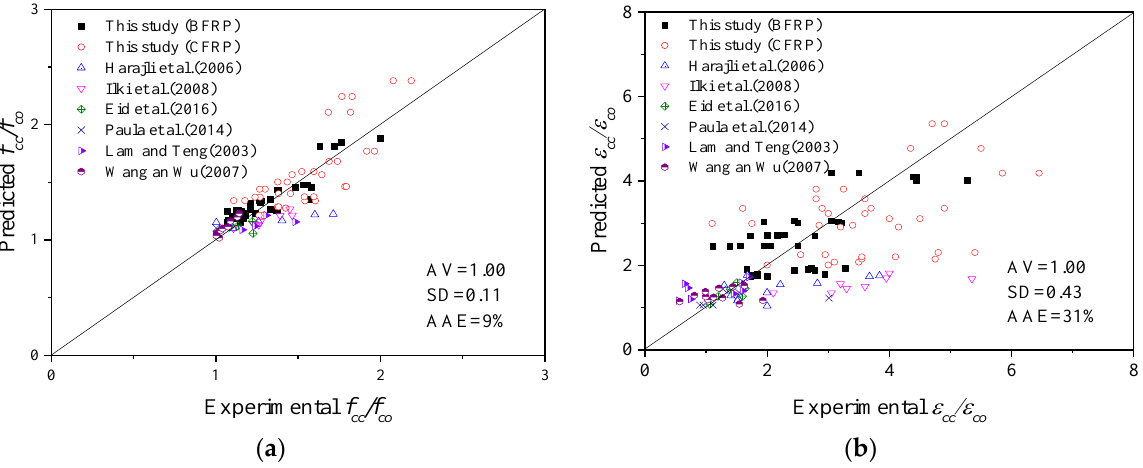
Figure 13. Comparison of the predicted results and test results of the peak point models: ( a ) Peak stress, ( b ) Peak strain. stress, ( b ) Peak